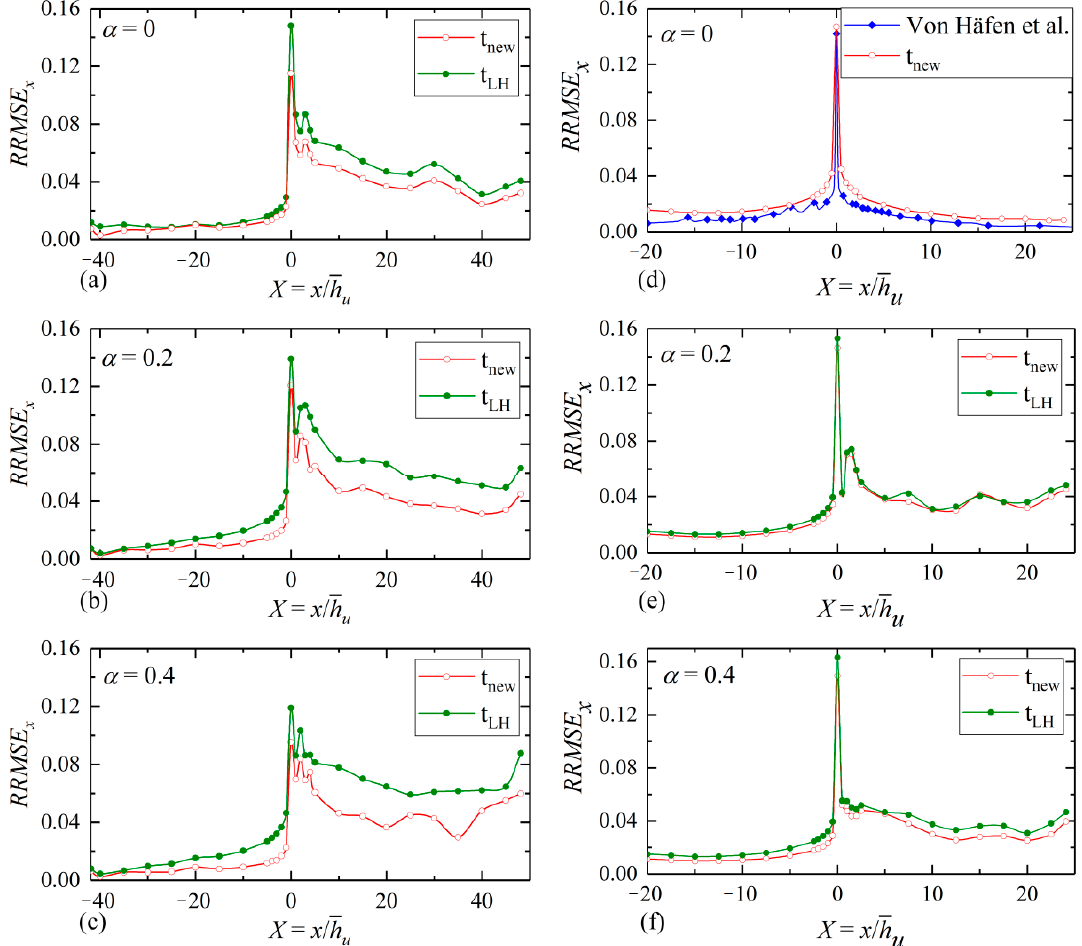
Figure 6. Profiles of RRMSE x for triangular channel (the left column) and rectangular channel (the right column). ( a ) α = 0 in the triangular channel; ( b ) α = 0.2 in the triangular channel; ( c ) α = 0.4 in the triangular channel; ( d ) α = 0 in the rectangular channel; ( e ) α = 0.2 in the rectangular channel; ( f ) α = 0.4 in the rectangular channel.